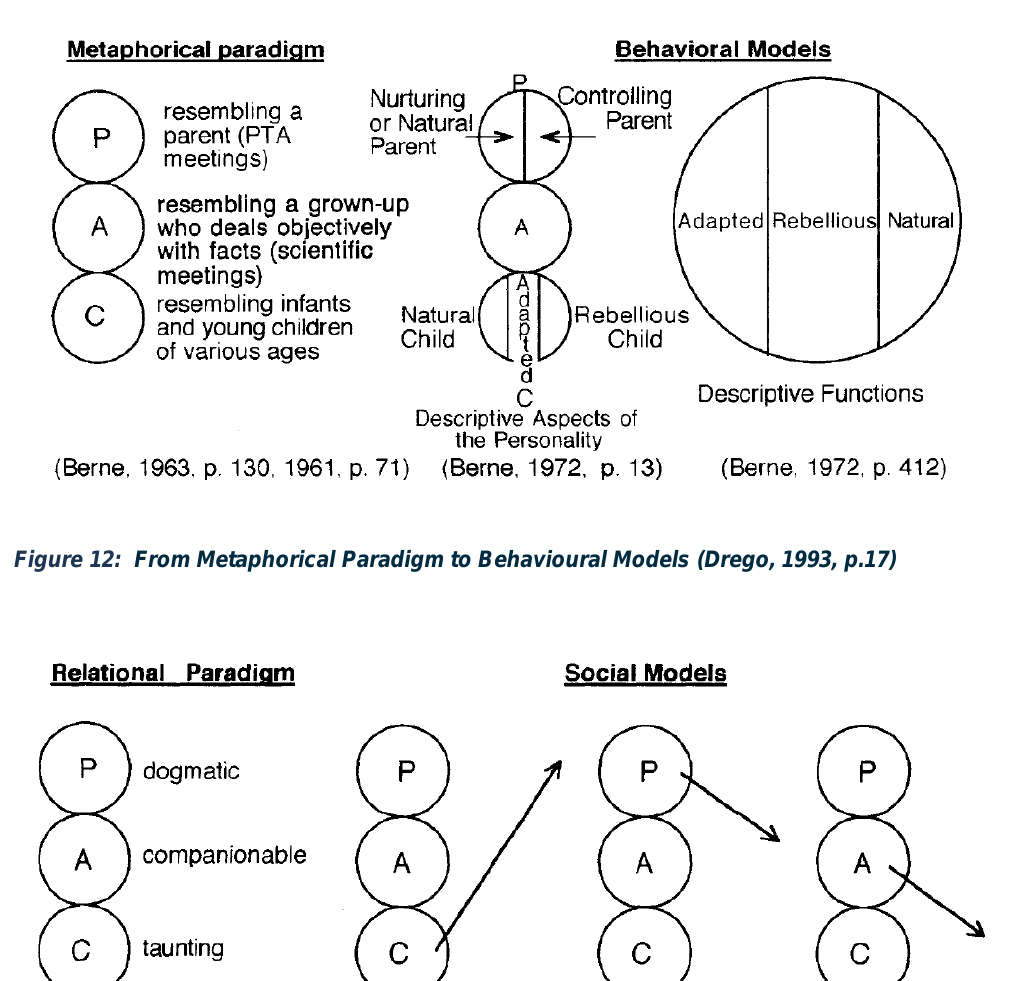
Figure 11: From Biographical Paradigm to Historical Models (Drego, 1993, p.14)